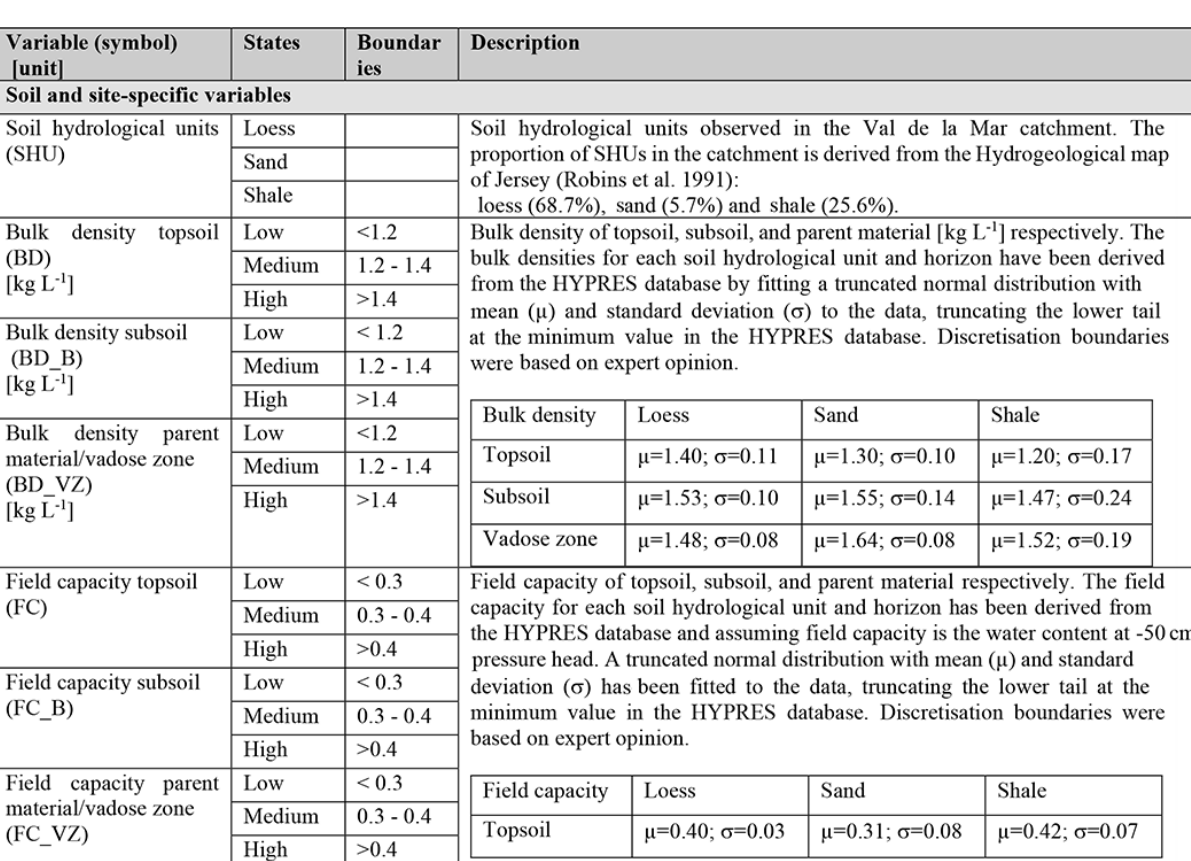
Table A1. The definition of model variables included in the Bayesian belief network, the definition of states and boundaries, and the infor- mation and assumptions used to populate prior probabilities or conditional probability tables for each